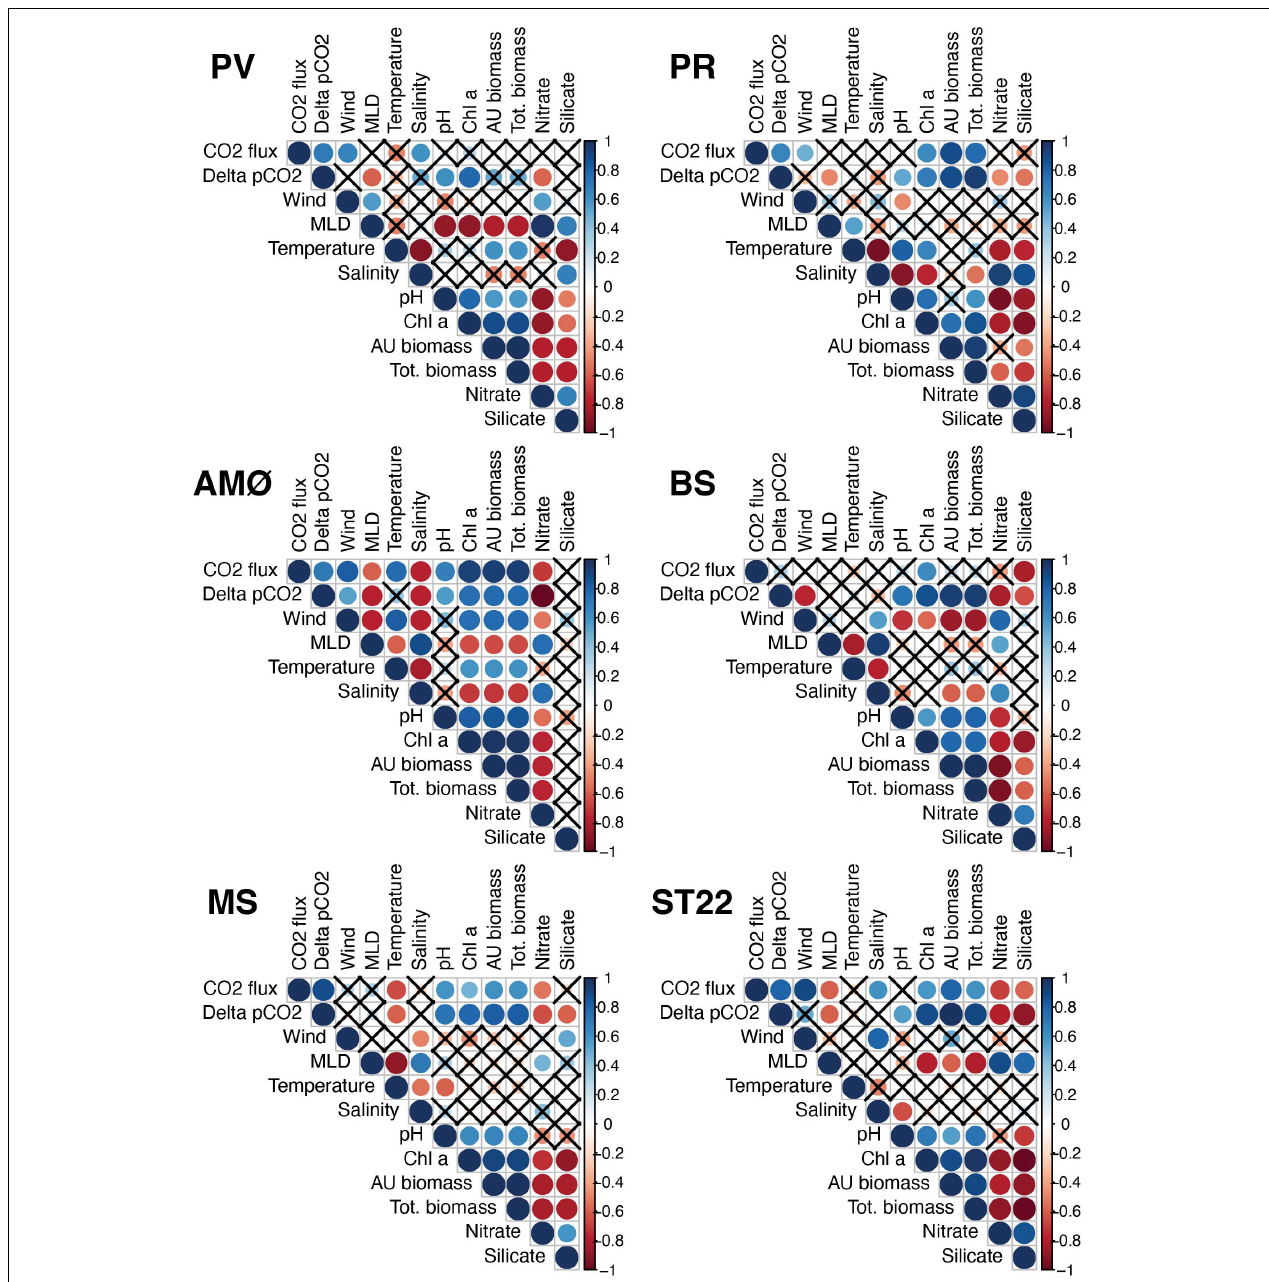
FIGURE 5 | Correlogram of Spearman’s correlation analysis per station. Correlation coefficients between variables are presented in colors and statistical significance is indicated by sizes. Blue color indicates positive and red color negative correlation. Non-significant correlations ( p > 0.05) are marked with a cross. Tot. biomass and AU biomass refer to total phytoplankton biomass and autotrophic phytoplankton biomass,